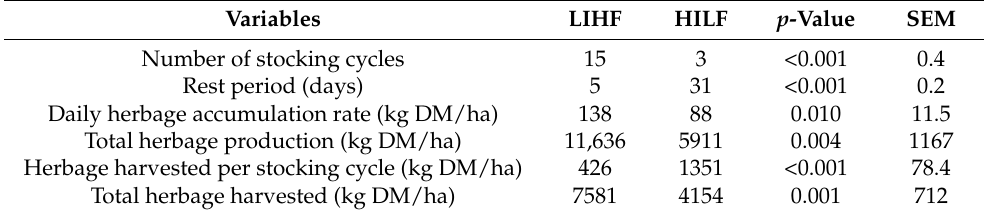
Table 2. Stocking cycles, herbage production, and total herbage harvested by beef cattle under different grazing management strategies (LIHF and HILF). Variables LIHF HILF p -Value SEM Number of stocking cycles 15 3 <0.001 0.4 Rest period (days) 5 31 <0.001 0.2 Daily herbage accumulation rate (kg DM/ha) 138 88 0.010 11.5 Total herbage production (kg DM/ha) 11,636 5911 0.004 1167 426 <0.001